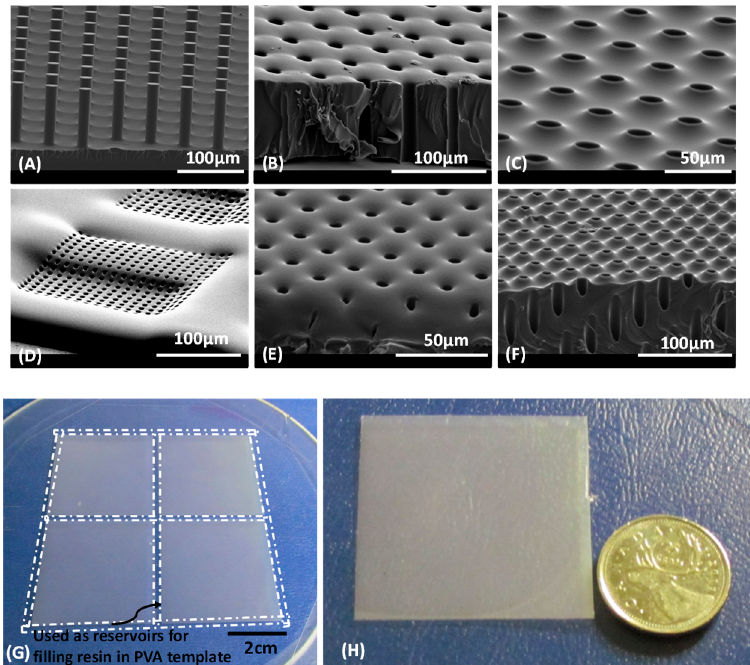
Figure 2. SEM images ( A – C ) of as-fabricated CUVR1534 membranes (80 µm thick, 16 mm by 33 mm area). ( D ) SEM image of the top side of a PDMS membrane. ( E ) SEM image of the top side of an 1161-M polymer membrane. ( F ) SEM image of an MD6945 membrane. ( G ) Wide area PDMS replica used in fabrication of PVA template. ( H ) One of four sections of a CUVR1534 membrane (30 µm thick, 40 × 40 mm 2 area).